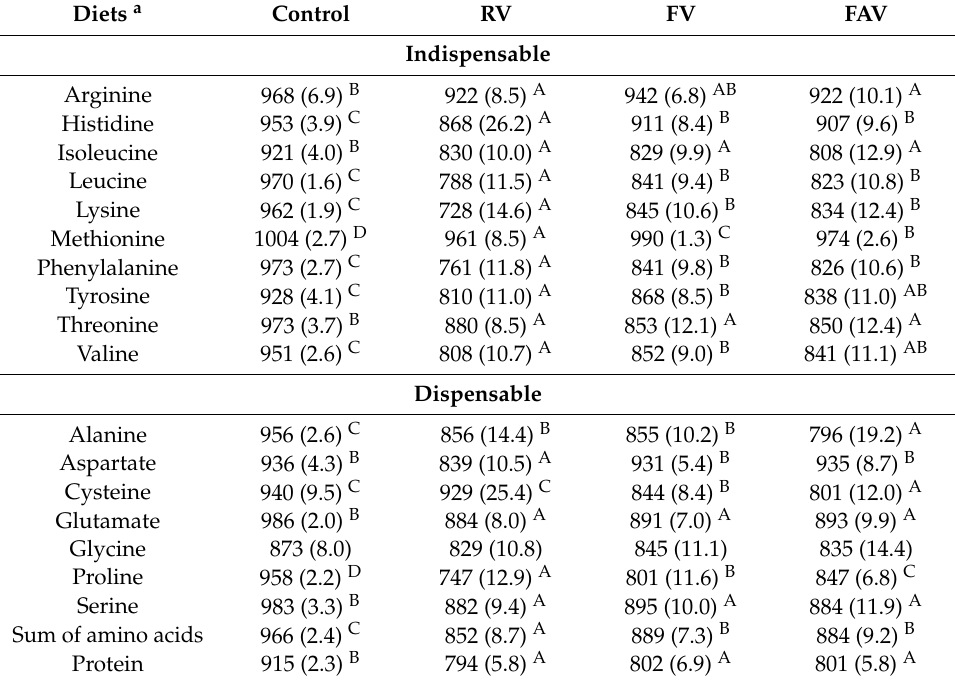
Table 5. True fecal digestibility, g · kg − 1 of amino acids in rats fed diets based on casein or cowpea as the only protein